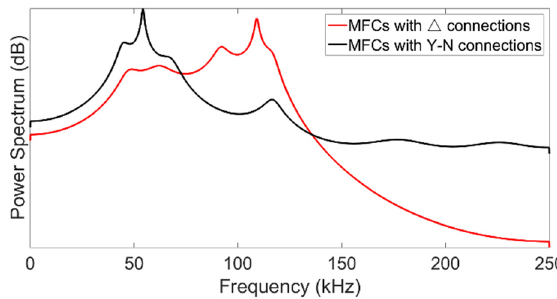
Figure 15. Power spectra of self-healing discharges in MFCs with different connections.